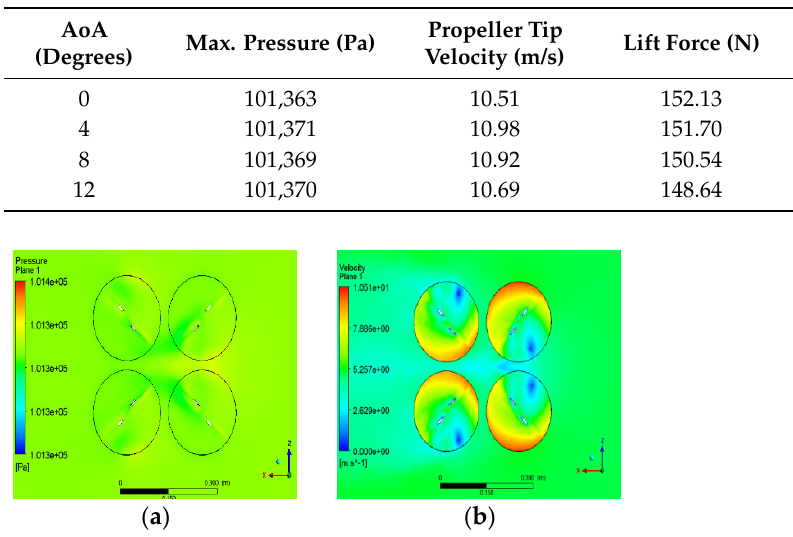
Table 14. Lift and drag force for different AoA during forward phase.